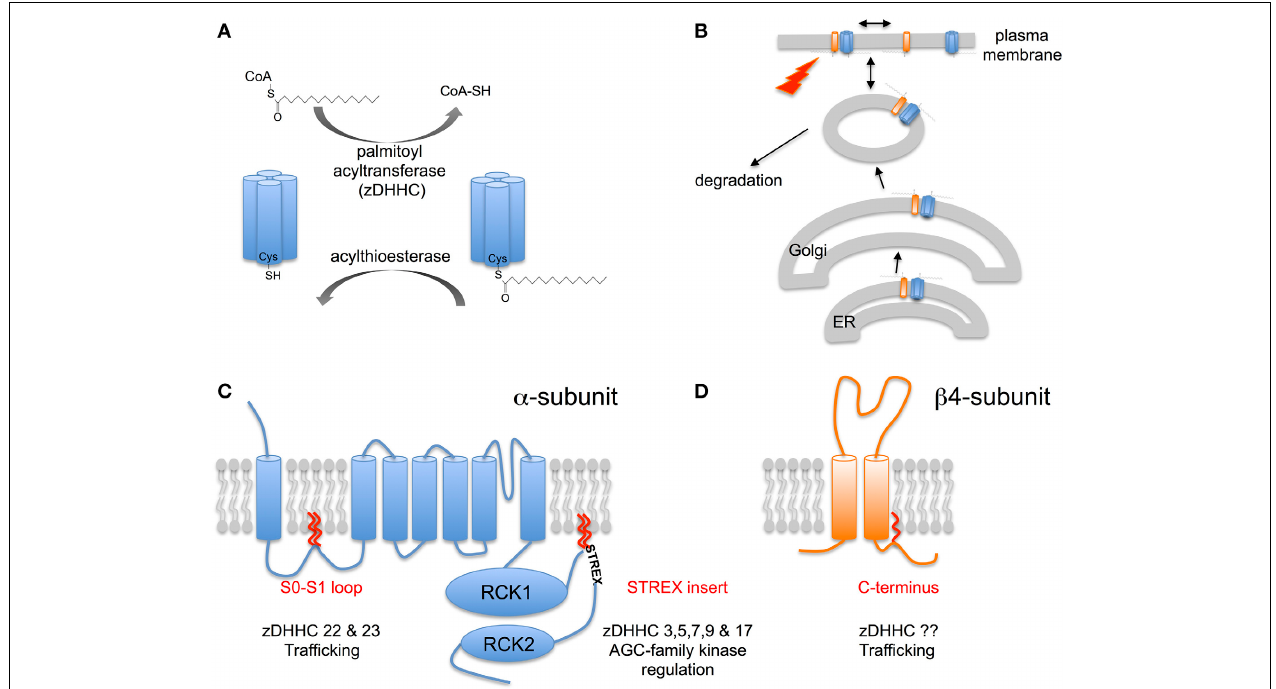
FIGURE 1 | S-acylation of BK channels. (A) Schematic of reversible enzymatic regulation S-acylation of proteins. Addition of lipid (typically palmitate) to cysteine residues in target proteins via a thioester bond is catalyzed by a family of palmitoyl acyltransferases (zDHHCs). Removal of lipid results from the action of acylthioesterases. (B) S-acylation controls multiple steps in the lifecycle of BK channels including control of forward trafficking, surface expression and intrinsic channel properties and modulation by other signaling pathways. (C) Schematic of the pore-forming α -subunit of the BK channel encoded by the single KCNMA1 gene. α -subunits are S-acylated at two distinct sites by distinct acyl transferase